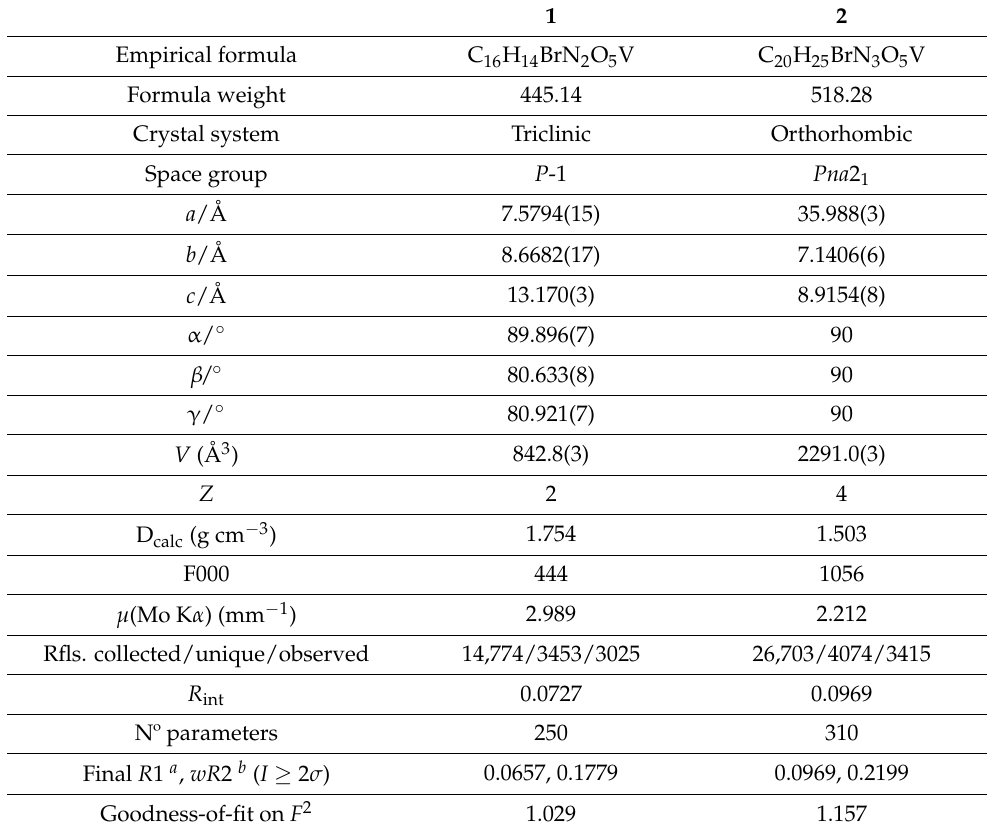
Table 1. Crystal data and structure refinement details for 1 and 2